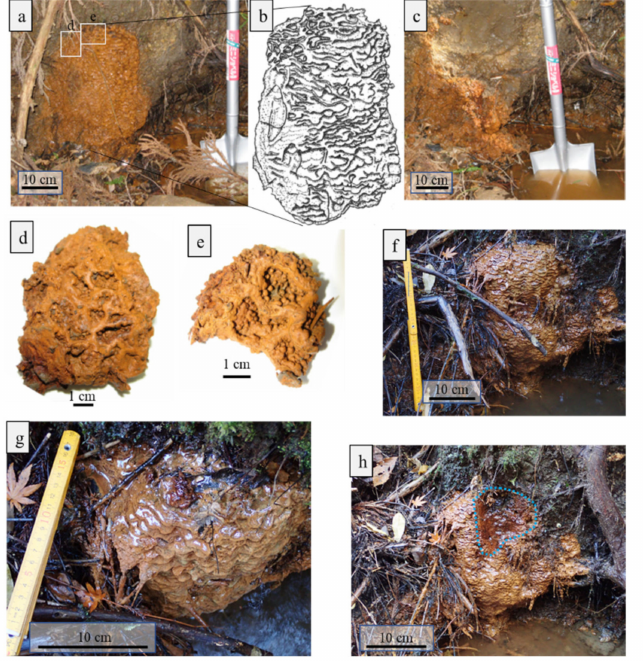
Figure 2. Photographs and a sketch of the ocherous aggregate at site 2. ( a ) Aggregate attached to the stream bank. ( b ) Sketch of the aggregate. ( c ) The stream bank after the aggregate was sampled in March 2007. ( d , e ) Enlarged photos of air-dried pieces from the “d” and “e” positions marked in ( a ), respectively. Dried rimstone pools have ocherous spheroids. ( f ) Side view and ( g ) top view photos of aggregate recovered in December 2019. ( h ) Parts (green dotted enclosed line) of the top of the aggregate were sampled in December